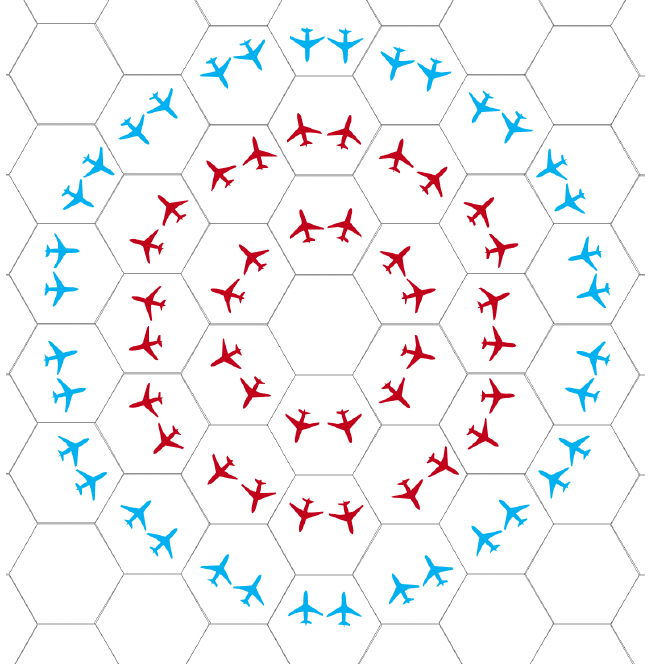
Figure 5. One group of UAVs surrounds the other